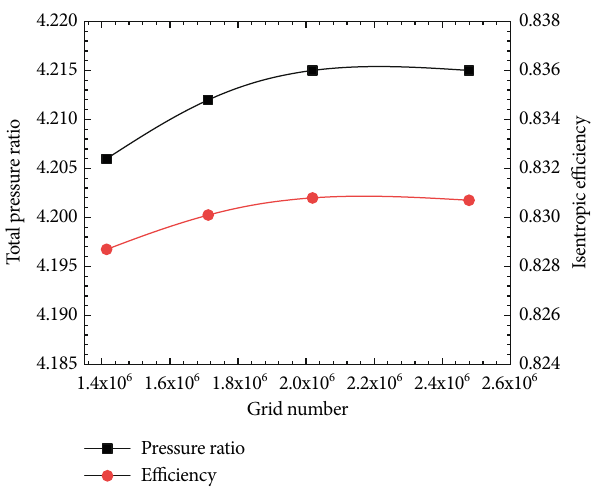
Figure 3: Performance predicted for di ff erent grid